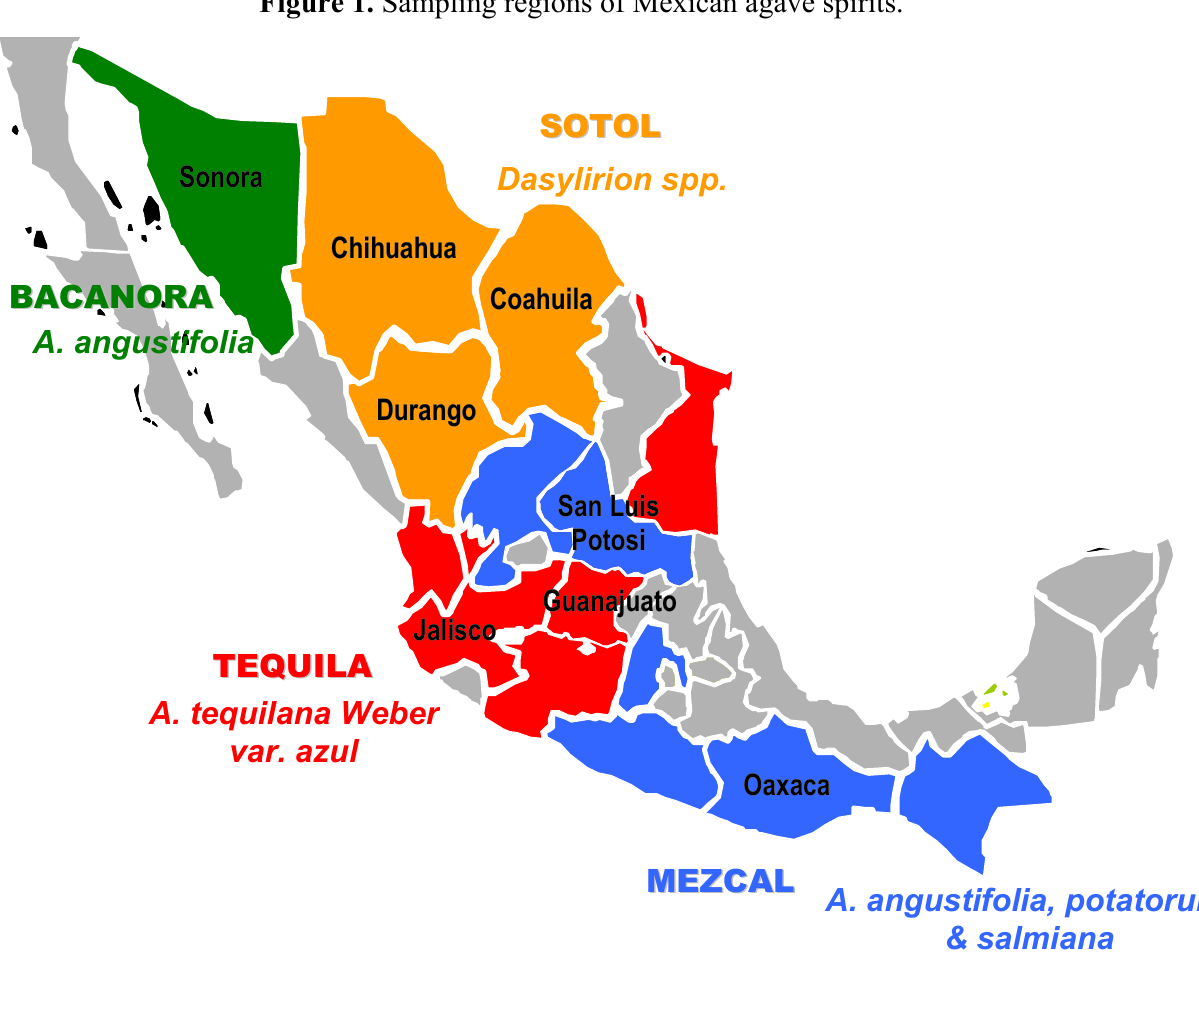
Figure 1. Sampling regions of Mexican agave